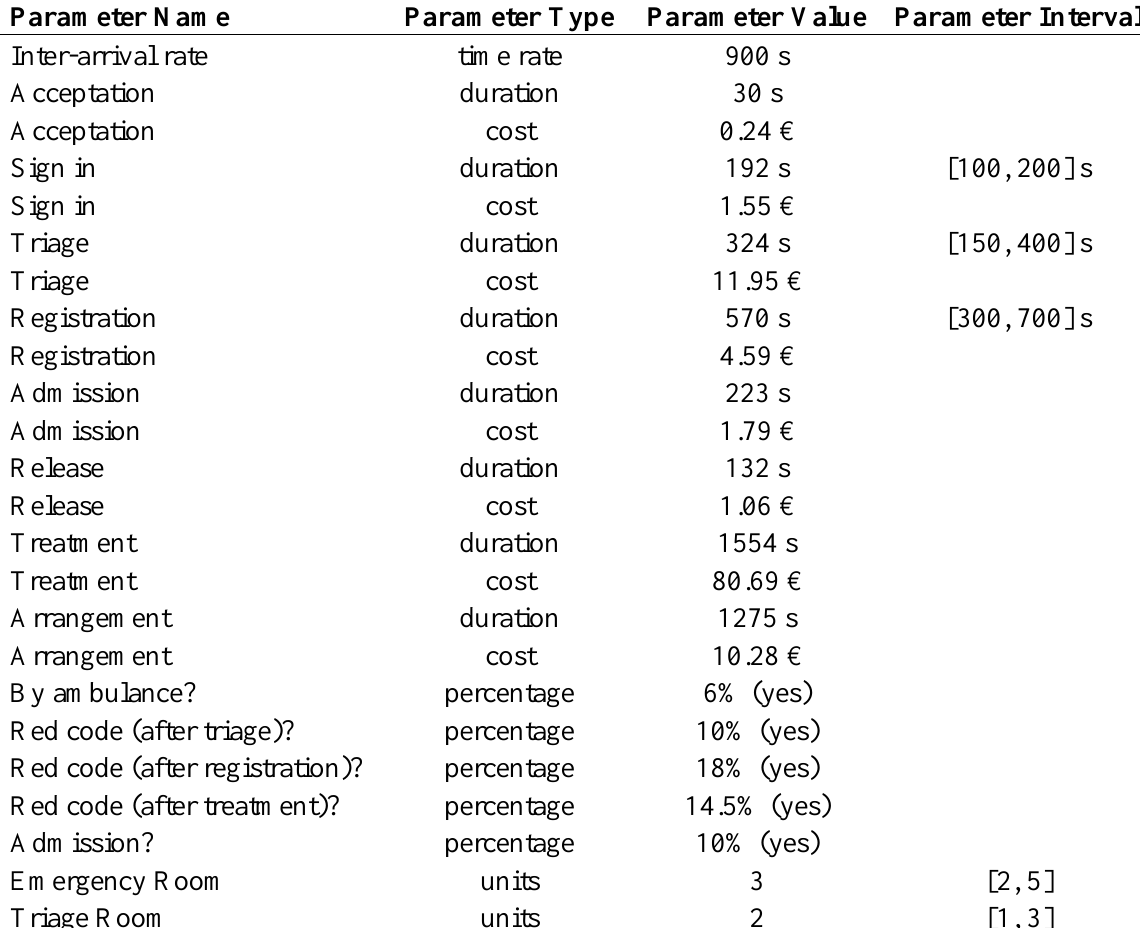
Table 9. Parameters and their values for the hospital scenario.